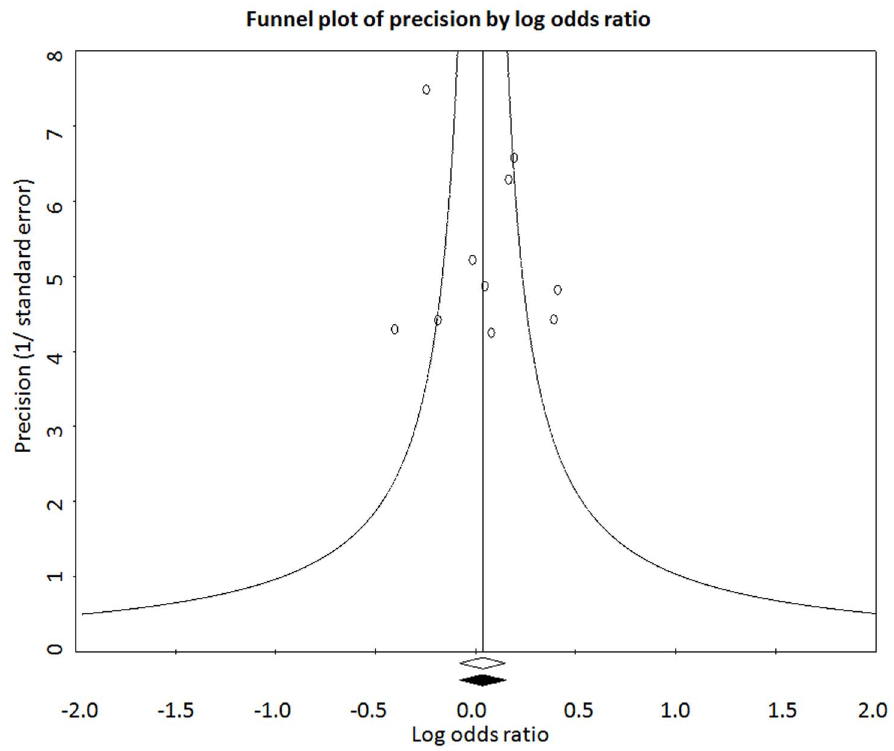
Figure 4. Funnel plot. Plot of precision by log odds ratio using fixed effect model for observed and imputed sets of studies.